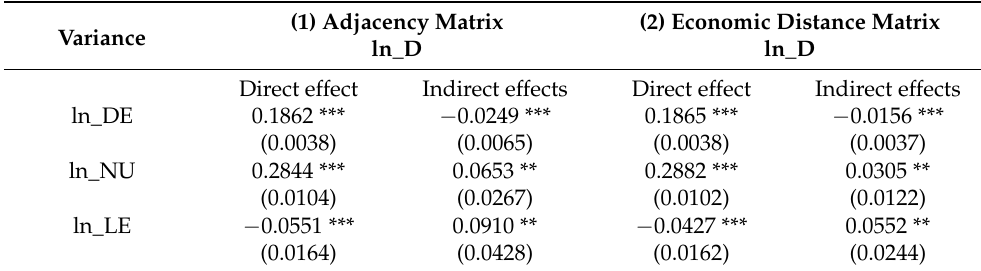
Table 9. Decomposition of spatial